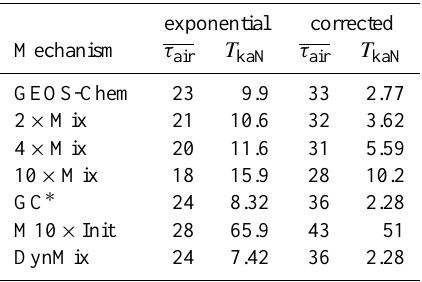
Table A1. Optimization results for stochastic convection using the pure exponential model and the model with correction for preferen- tial sampling. Table includes optimal air parcel lifetime ( τ air ) and Anderson Darling goodness-of-fit test value ( T kaN ) for alternative background mixing rate sensitivities. The predicted NO x :HNO 3 is statistically different than observations when T kaN is greater than 3.752 ( α = 0 .